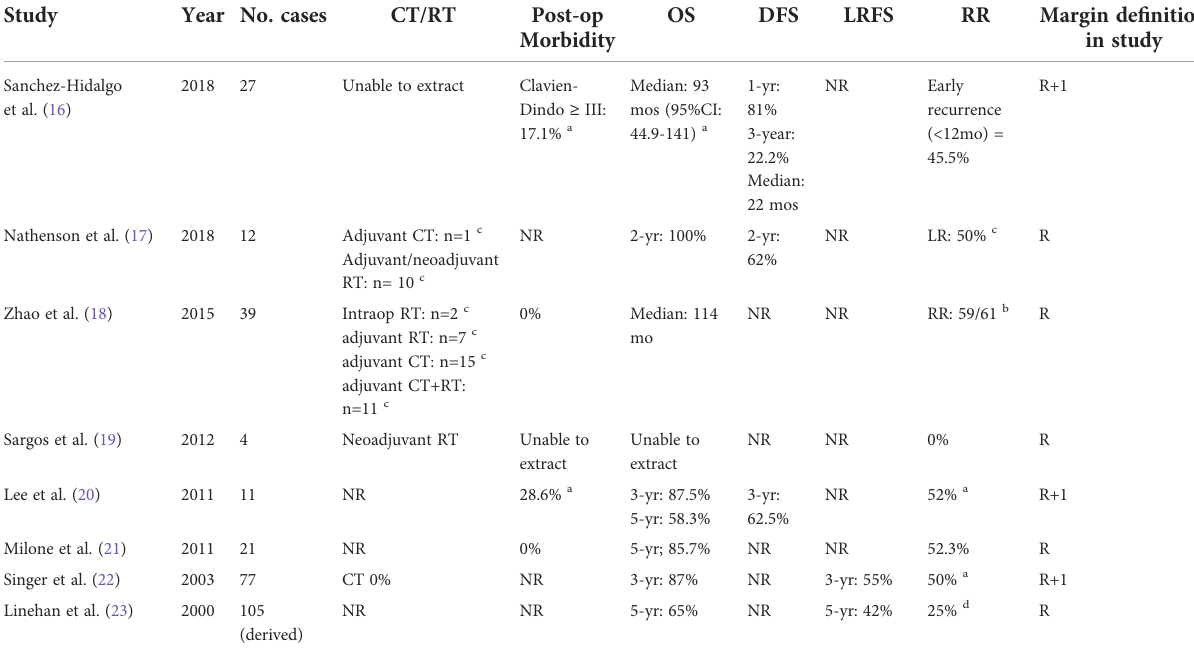
TABLE 2A Summary of cohort studies which included patients receiving R0-margin